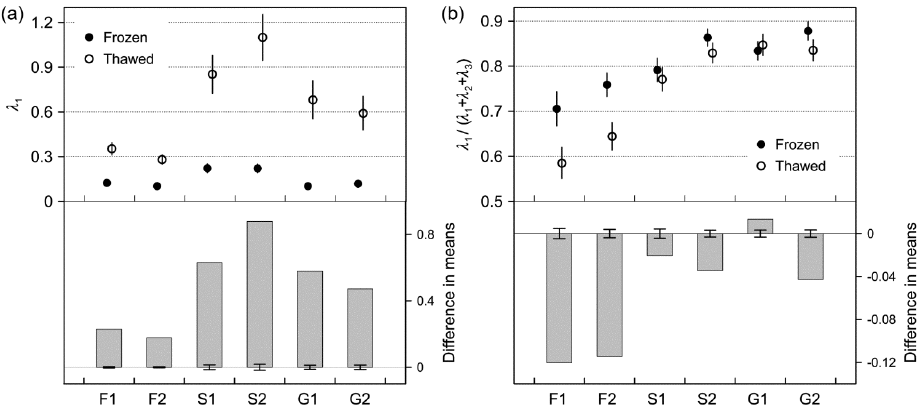
Figure 6. Seasonal variations of ( a ) the largest eigenvalue ( (cid:2019) (cid:2869) ) and ( b ) its relative contribution to the total backscatter, (cid:2019) (cid:2869) /((cid:2019) (cid:2869) + (cid:2019) (cid:2870) + (cid:2019) (cid:2871) ) . Vertical error bars in the lower plot indicate 99% confidence interval for the hypothesis test (cid:1834) (cid:2868) : (cid:2020) thawed = (cid:2020) frozen .